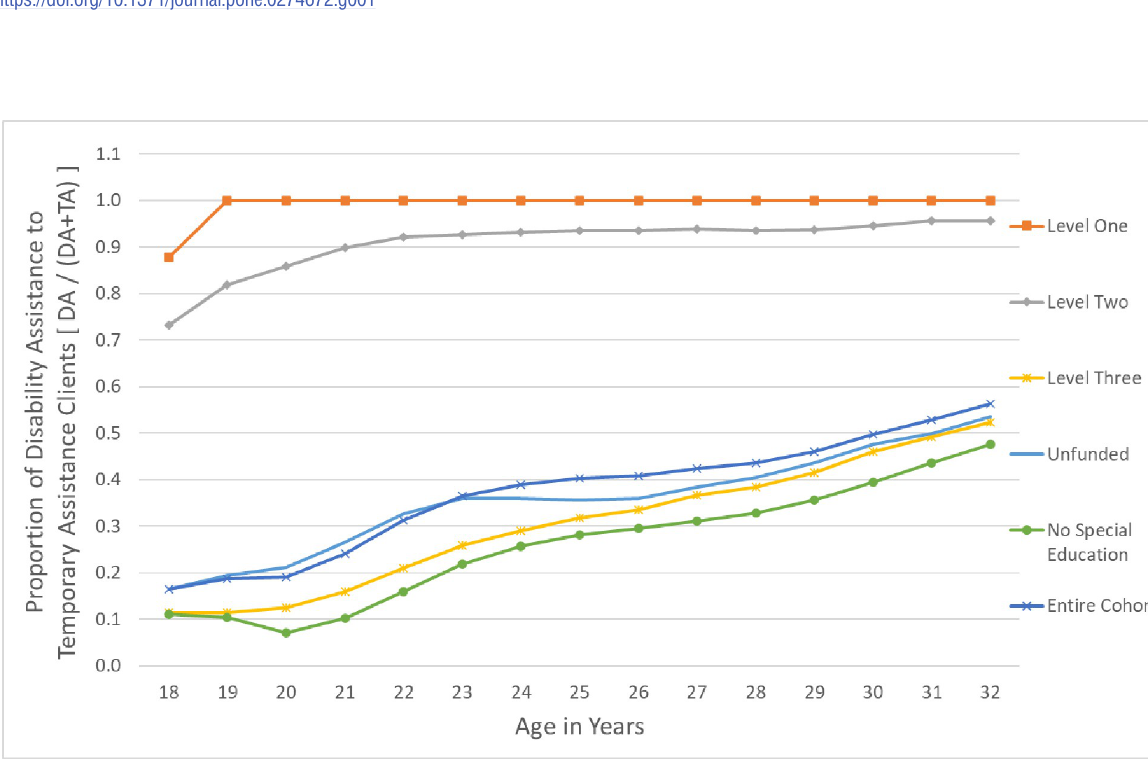
Fig 2. Proportion of Disability Assistance to temporary assistance clients among those previously using special education. Relative use of British Columbia Employment and Assistance–Disability Assistance (DA) program to Temporary Assistance (TA) program over young adult years, by level of special education received in primary